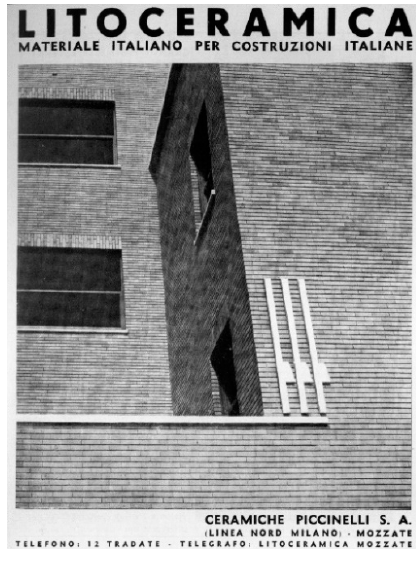
Figure 1. Litoceramica Piccinelli advertising. Photo from (Baliviera et al. 1935).